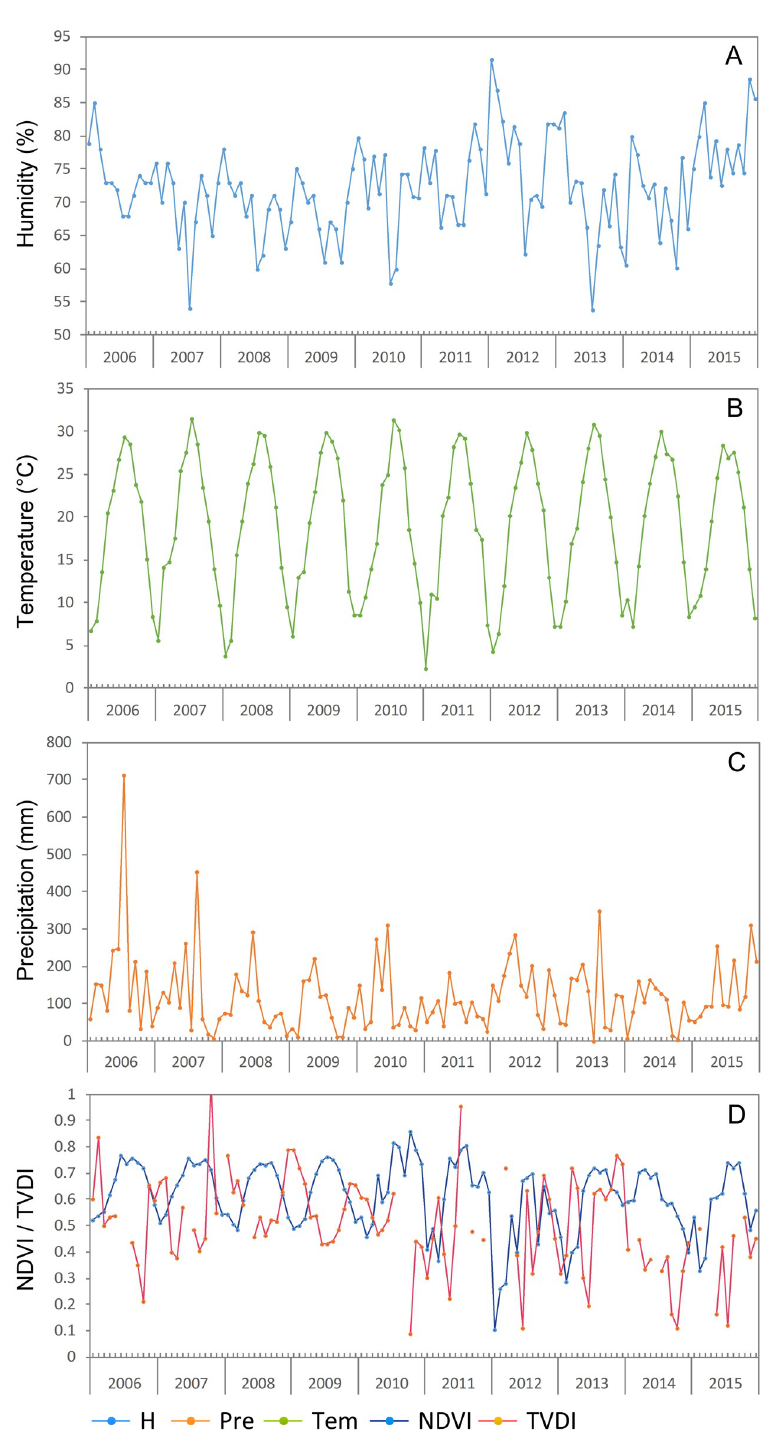
Fig 5. Monthly environmental variables data for Chenzhou, 2006–2015. The x-axis is arranged by year and within the segment of each year the values are ranked by month from January to December. Tem: temperature (˚C), H: relative humidity (%), Pre: precipitation (mm), NDVI: the normalized difference vegetation index, TVDI: the temperature vegetation dryness index (the values in some moths were abnormal and have been removed from the